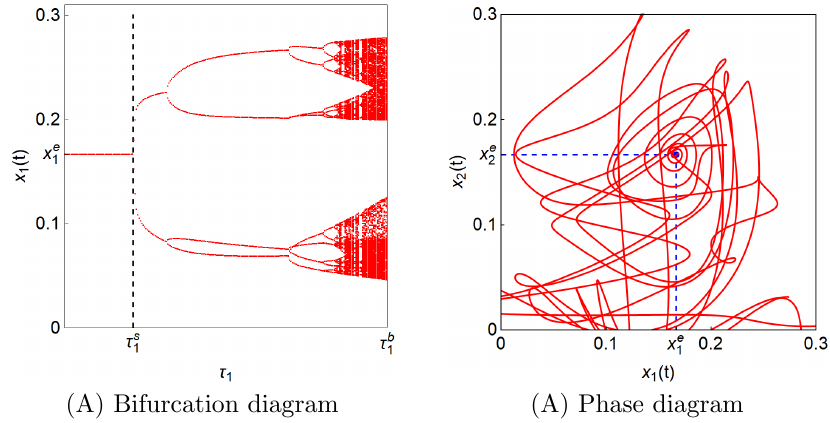
Figure 10. Possible global dynamics for various values of τ 1 and τ 2 = 1 :